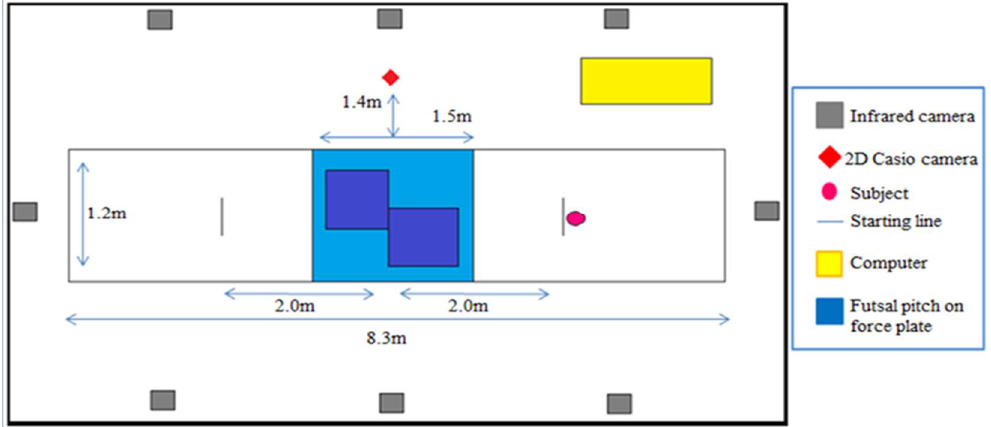
Figure 1. The experiment